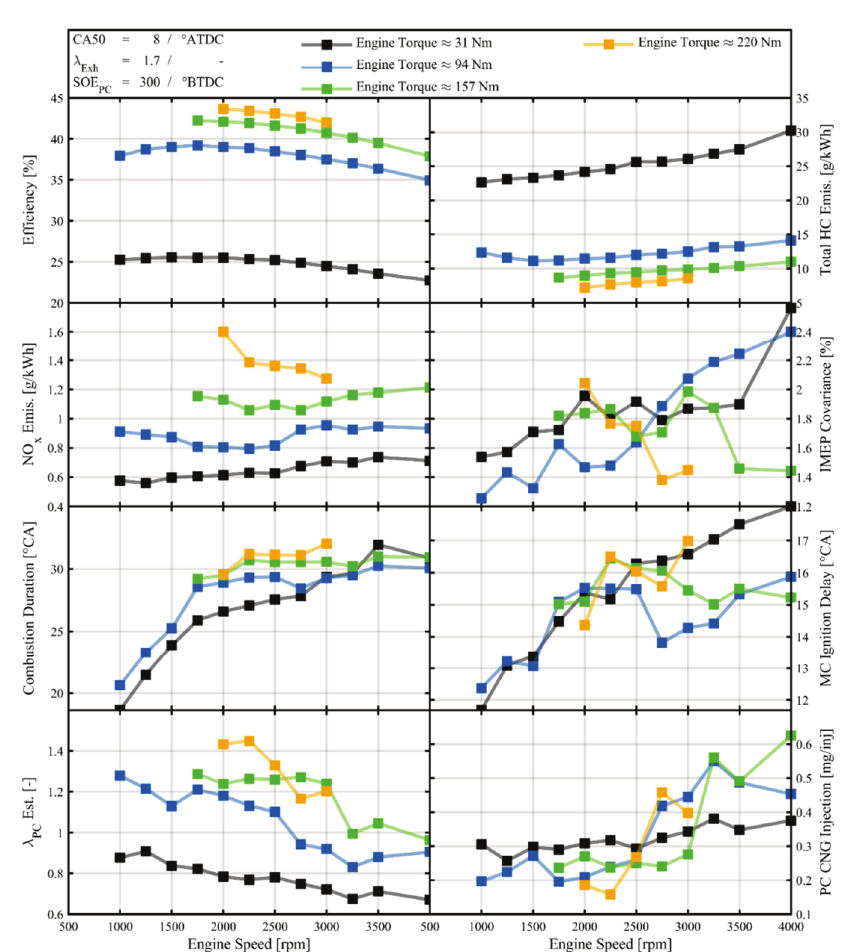
Fig. 11. Engine speed and load variation at an air-to-fuel ratio of λ Exh = 1.7. The amount of CNG injected into the pre-chambers is adapted manually with the objective to increase engine efficiency and emissions for each operating point